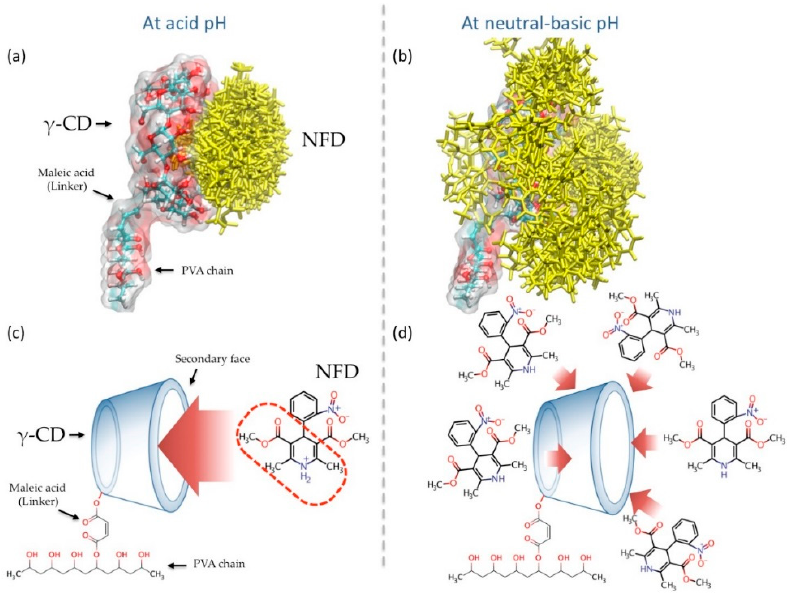
Figure 2. ( a , b ) Spatial distribution of the 200 conformations with the best interaction energy for the complexes: PVAchain-MaleicAcid- γ -CD/NFD at acid and neutral-basic pH, respectively. ( c , d ) Representative description of the inclusion processes that led to the formation of the γ -CD/NFD complex at acid and neutral-basic pH, respectively.